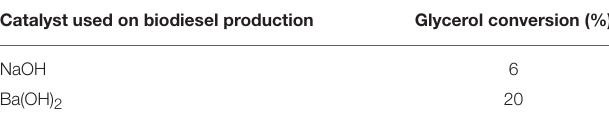
TABLE 2 | Crude glycerol